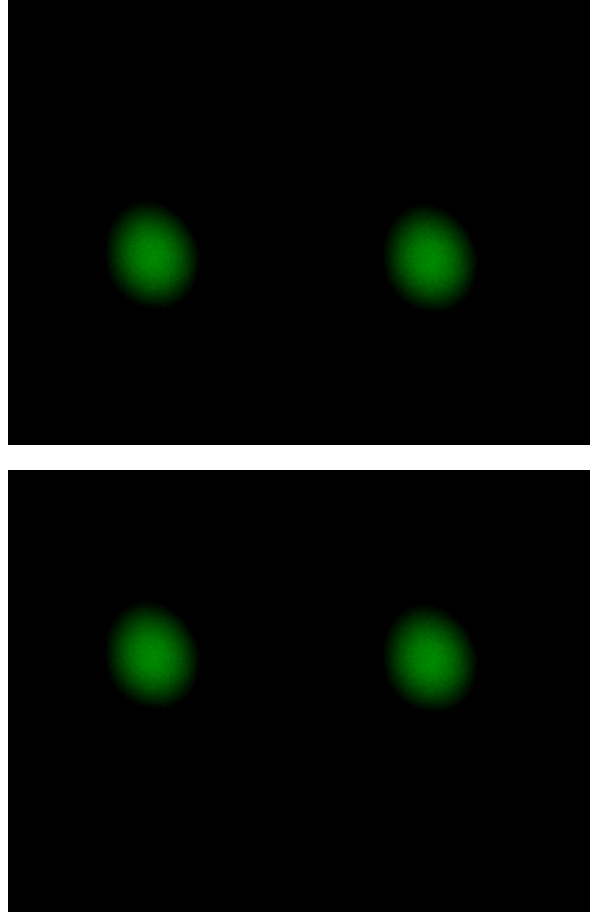
Figure 6. Enlargements of two frames obtained for the northern target at the beginning (top) and at the end of the test (bottom panel). The left and right footprints are generated by the left and by the right pointers, respectively.